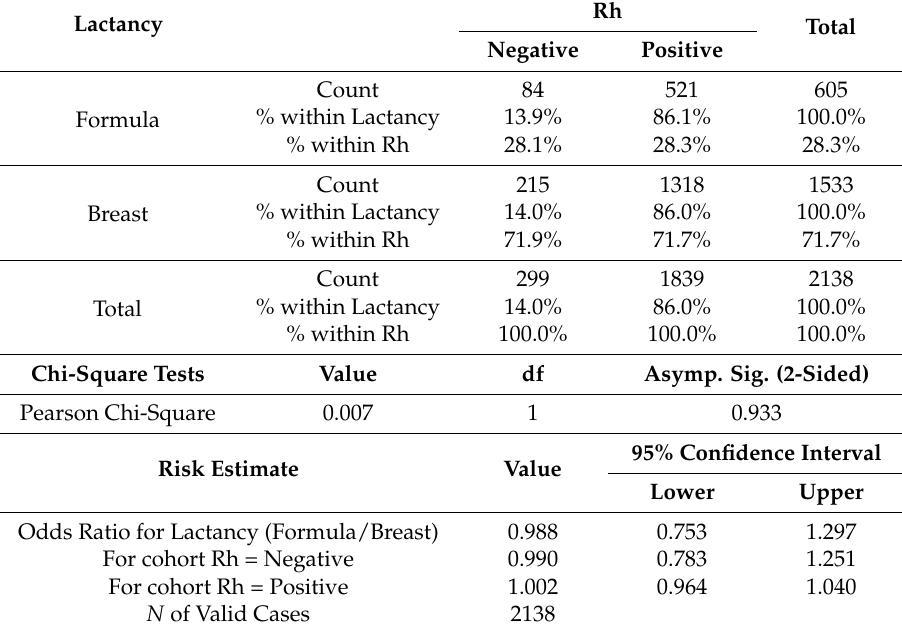
Table 8. Crosstab Lactancy vs.